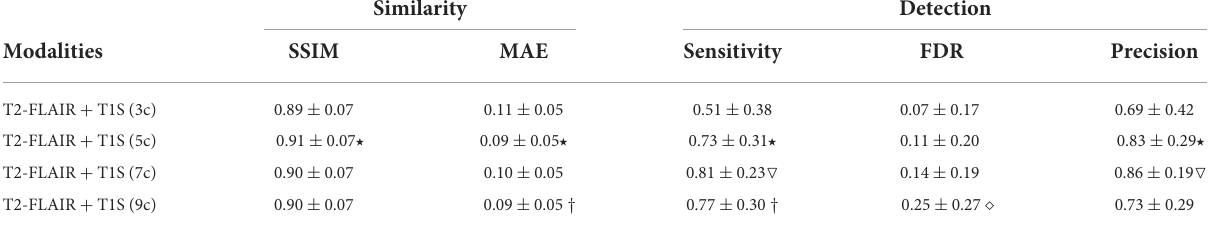
TABLE 1 Similarity between images and performance of the lesion detection algorithm when using 3, 5, 7, and 9 clusters in the synthesis of T1-w images.